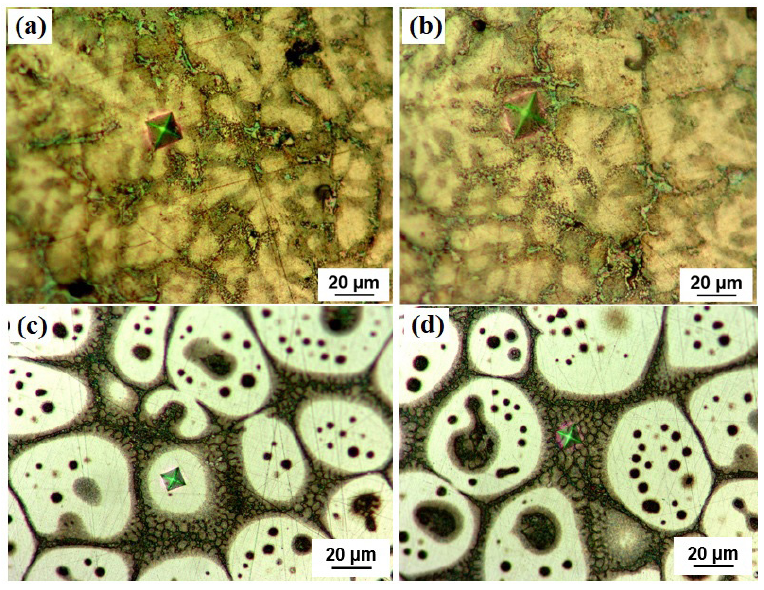
Figure 15. Microhardness of the as-cast of ZA27 pure alloy before and after the SIMA process applied: a) indentation of the dendrite score, (b) indentation of the interdendritic region, (c) indentation of the globular phase and (d) indentation of the interglobular phase.